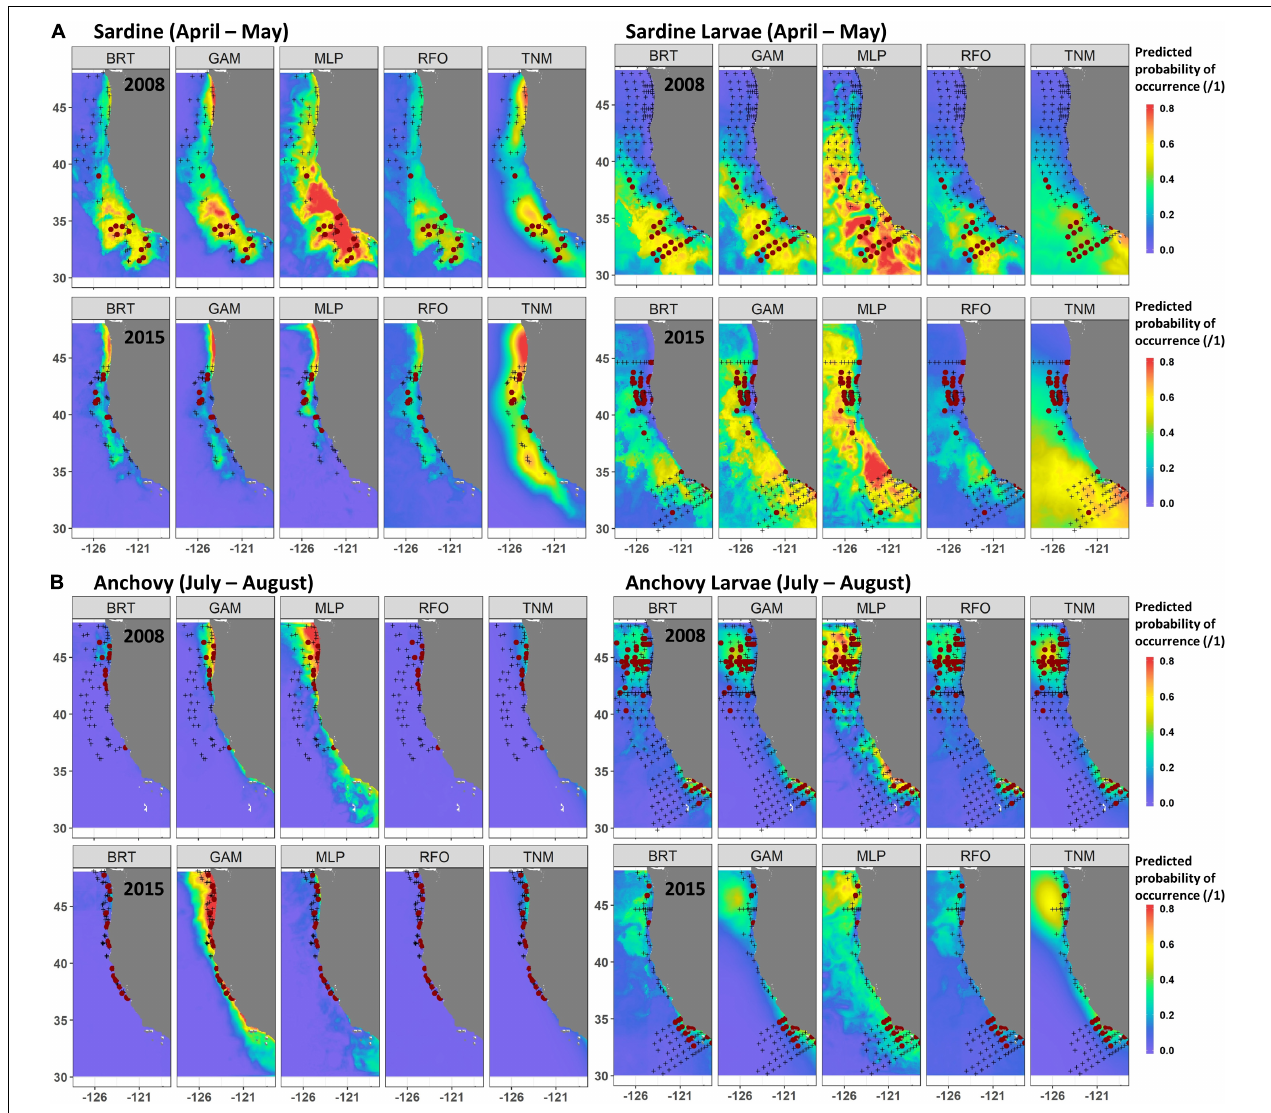
FIGURE 6 | Predicted and observed distributions of sardine and sardine larvae during April–May (A) , and anchovy and anchovy larvae during July–August (B) , for two examples years. SDM predictions are a mean across Experiment 1 SDM ensembles (see Figure 2 ). Observed presences are shown in maroon dots, observed absences by black